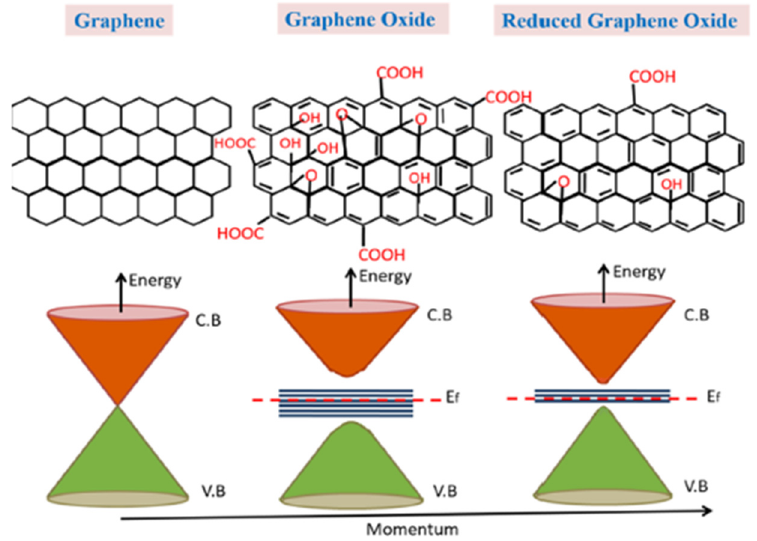
Figure 36. Schematic representation of lattice structure and corresponding energy diagrams of graphene, graphene oxide (GO) and reduced graphene oxide (rGO) [149]. Copyright (2018), with permission from Nature Publisher Group.